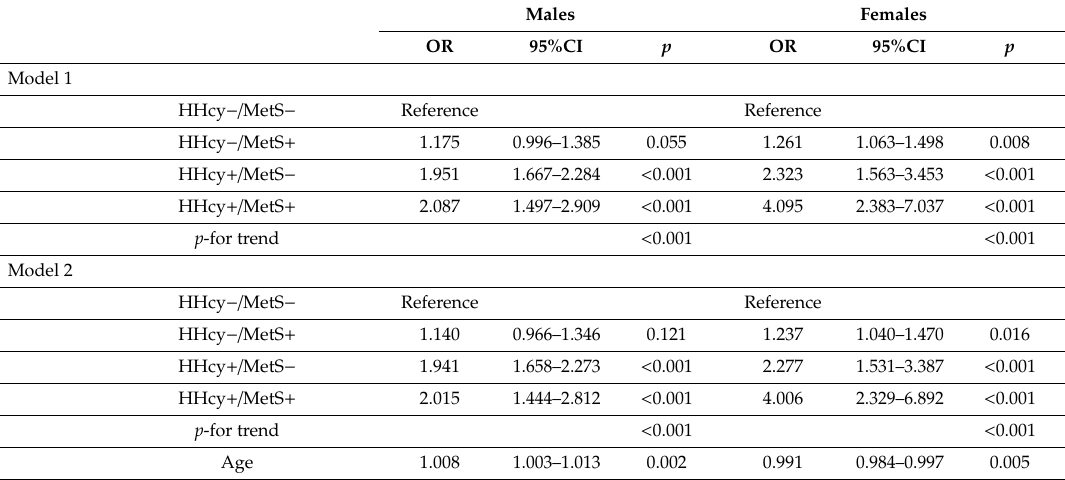
Table 2. Odds of CKD for the presence or absence of HHcy and MetS.